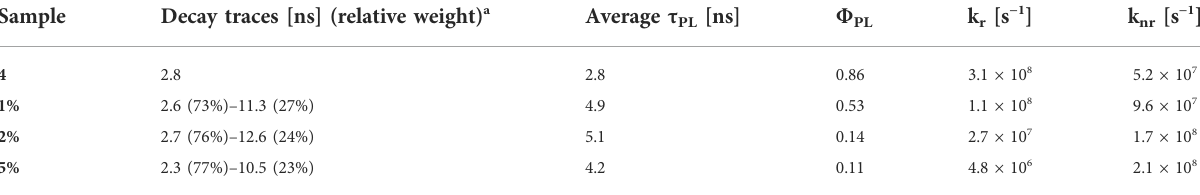
TABLE 1 Excited-state lifetimes, fl uorescence quantum yields, radiative rate constants (k r ) and non-radiative rate constants (k nr ) of the BOPHY1- PMOs. Sample Decay traces [ns] (relative weight) a